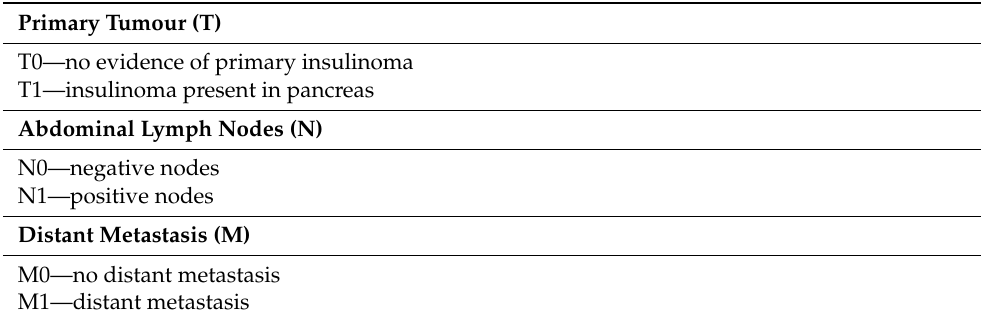
Table 1. TNM classification of canine